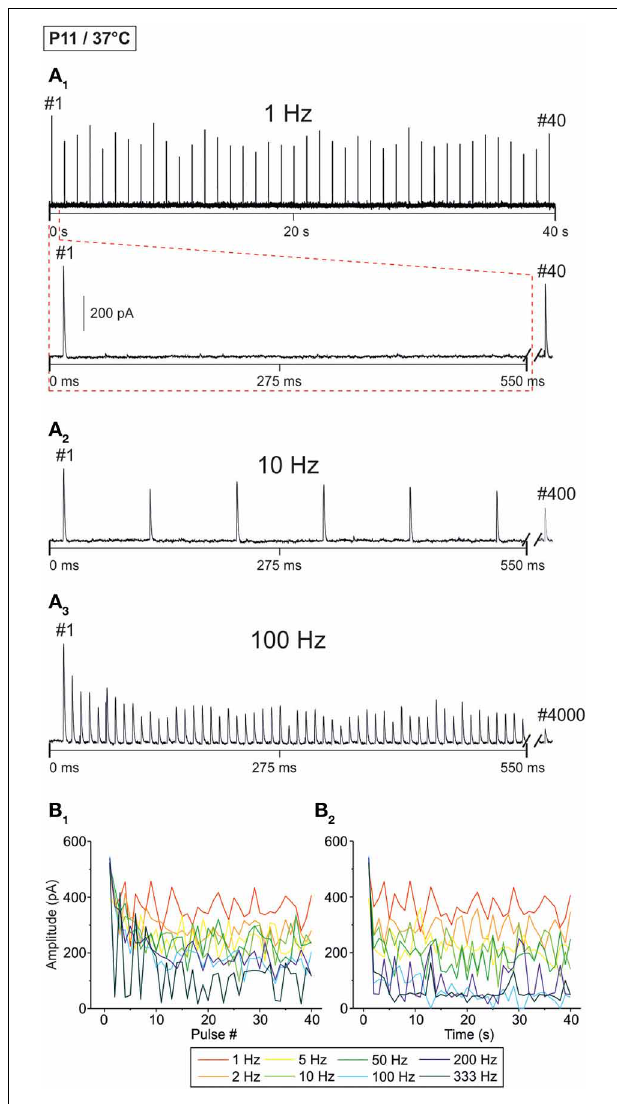
FIGURE 2 | Frequency-dependent changes in evoked glycinergic IPSCs obtained at P11 and physiological temperature (37 ± 1 ◦ C). (A 1 ) Original 40s recording of a representative LSO neuron during 1Hz stimulation (top). Thefirst550msaretime-expandedinthebottomtrace(seered-stippledline). The last IPSC during the 40-s-period is shown on the right and depicted by its pulsenumber(#40).The200pAcalibrationbarisalsovalidforpanels (A 2 ,A 3 ) . (A 2 ,A 3 ) IPSCs during 10 and 100Hz stimulation, respectively, from the same neuron as in panel (A 1 ) . Similar to (A 1 ) , the very last IPSC during the 40-s-period is shown on the right (#400 and #4000, respectively). (B 1 ) Time course of IPSC peak amplitudes from three LSO neurons at eight stimulation frequencies, ranging from 1 to 333Hz (for color code, see inset). Peak values tothefirst40pulses(#1–40)areplotted. (B 2 ) Like (B 1 ) ,butdepictingthetime course of IPSC peak amplitudes during the complete 40-s-periods. For each stimulationfrequency,peakamplitudesweresampledat1-s-intervals.Notice the frequency-dependent short-term depression